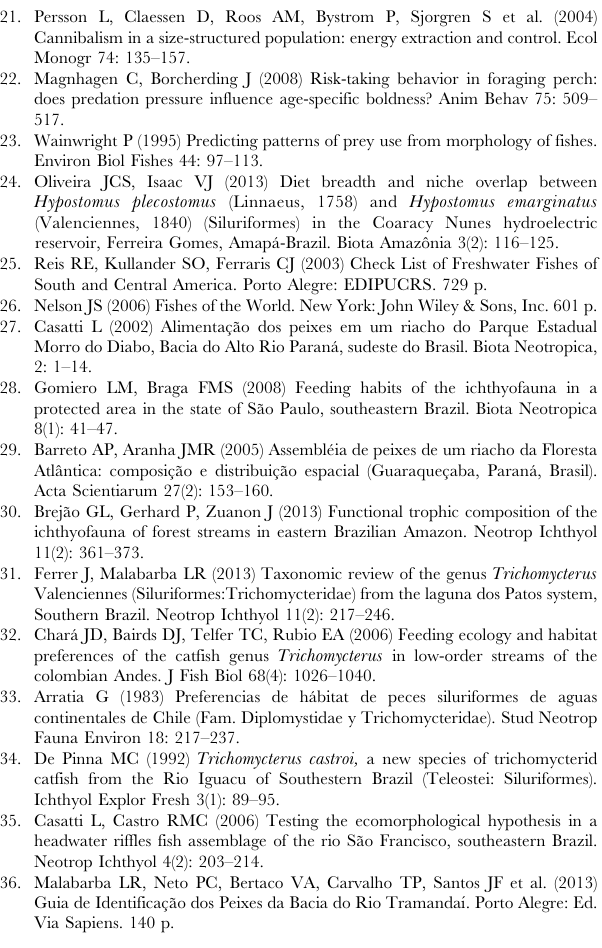
Table S1 Number of analyzed stomachs per sample unit (stream and sampled month) for each size class for the species studied. For stream and specie/size class code see Material and Methods and Table 1. Table S2 Stomach content analyzed (% by volume) for the species of Siluriformes sampling in ten streams in Alto Jacuı´ sub-basin. For species and streams code see Material and Methods and Table 1. Asterisk indicates values less than